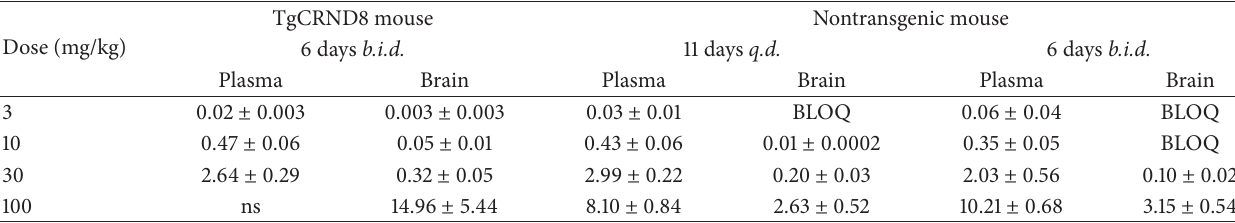
Table 3: Concentration of SCH 697466 ( 𝜇 M) in plasma and brain for various sub-chronic studies in TgCRND8 and non-transgenic mice. TgCRND8 mouse Nontransgenic mouse Dose (mg/kg) 6 days b.i.d. 11 days q.d. 6 days b.i.d. Plasma Brain Plasma Brain Plasma